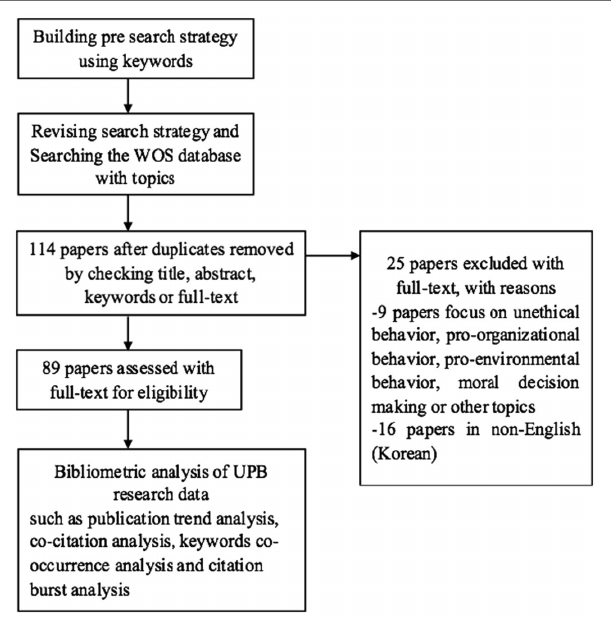
FIGURE 1 | UPB research search and selection process (Based on the PRISMA 2020